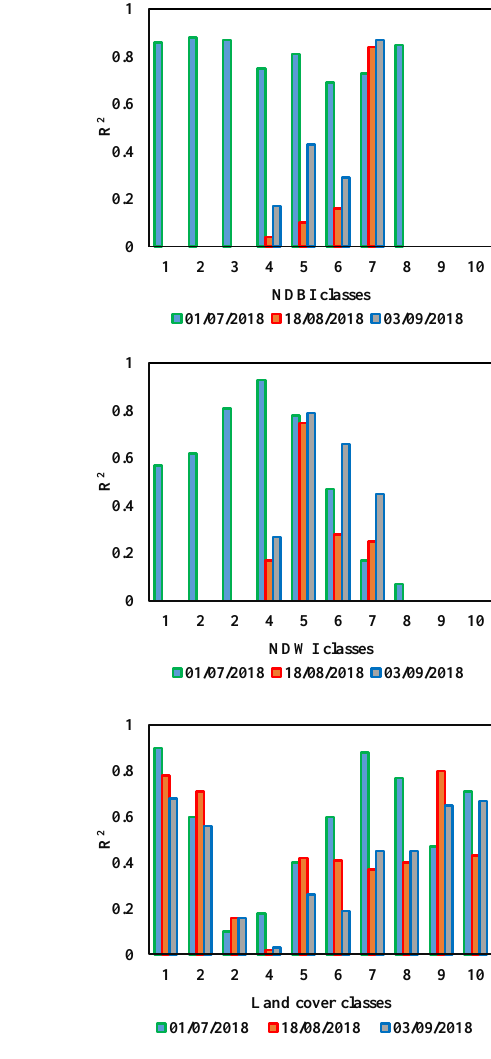
Figure 4. The values of NSTLR and R 2 in different classes of NDVI, NDBI, NDWI and land use at different dates.